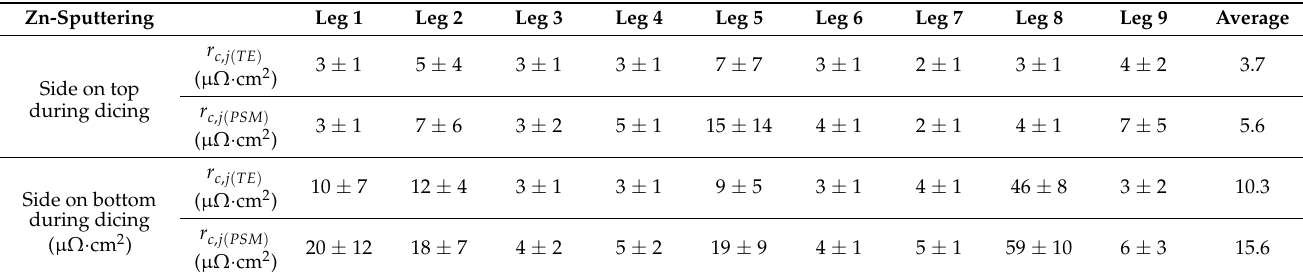
Table 3. Specific electrical contact resistances r c on both sides of legs cut from a pellet contacted with Zn-coated Al foils. No leg from this sample broke.